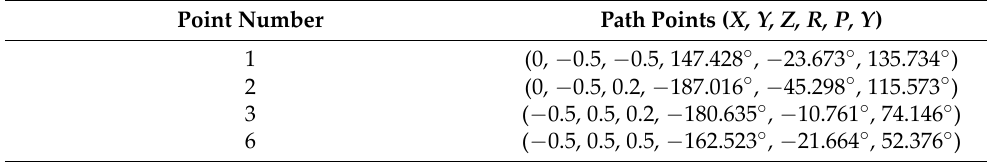
Table 2. Robot cartesian space path points.